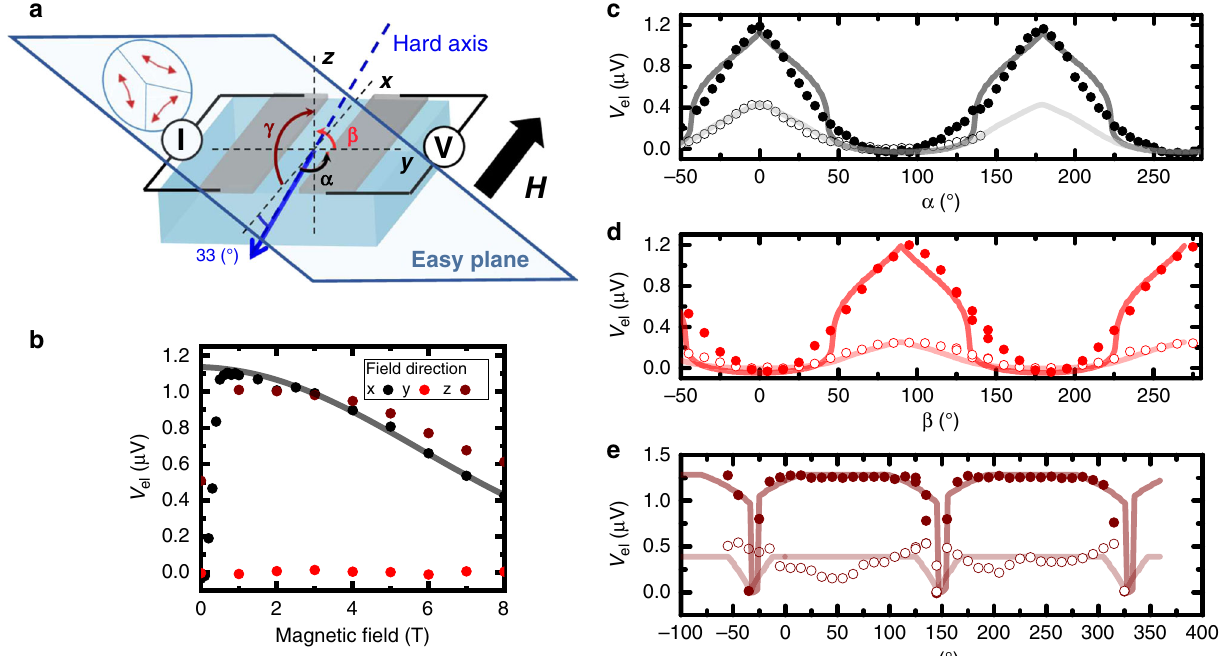
Fig. 2 Spin transport in the easy-plane phase. a Sketch of the x-oriented devices relatively to the (111) easy-plane. α is the (xy) angle between the applied fi eld and the x -axis. β is the (yz) angle between the applied fi eld and the y -axis. γ is the (xz) angle between the applied fi eld and the x -axis. b Spin-transport signal for fi elds along the x , y , and z directions (black line corresponds to a fi t based on phenomenological model, described in the text, based on correlated pairs of linear spin waves). c – e Spin-transport signal in the α , β , and γ planes. Filled and open symbols correspond to an applied fi eld of 0.5 and 8 T, respectively (shaded lines correspond to fi ts based on the phenomenological model based on pairs of linear spin waves. For modeling we used the following data: exchange fi eld H ex = 1040 T, H DMI = 2.72 T, H an,in = 24 μ T as in ref. 27 ). Error bars from counting statistic are smaller than the symbol